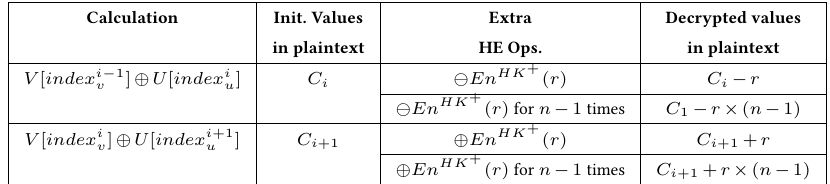
Figure 8. Malicious repetition attack